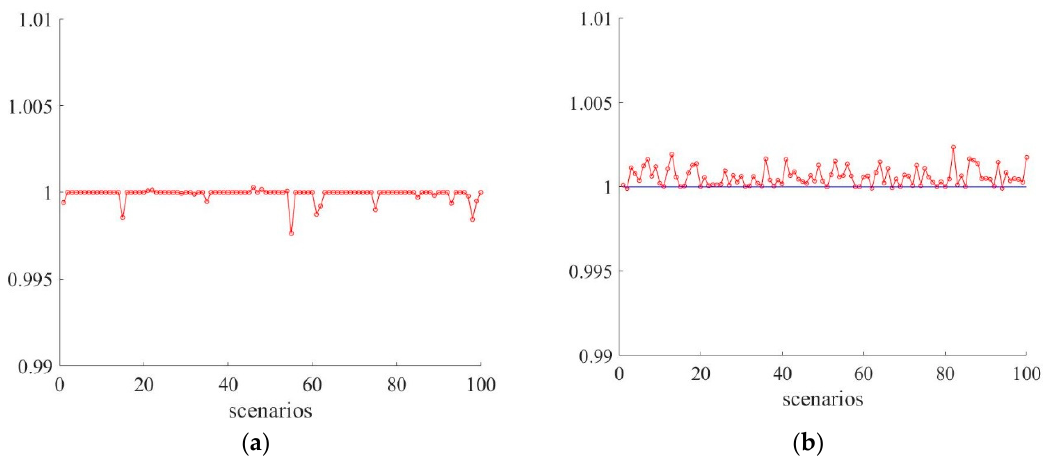
Figure 4. The relative objective value obtained by the GA compared to that of the multi-scenario cooperative evolutionary (MSCE). ( a ) H-95 with p = 10; ( b ) C-668 with p = 10.